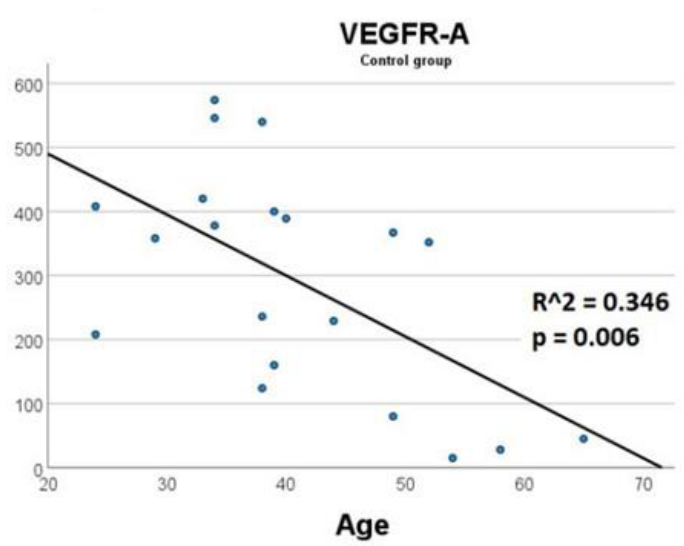
Figure 4. The relationship between the levels of VEGF-A and age in the control group.